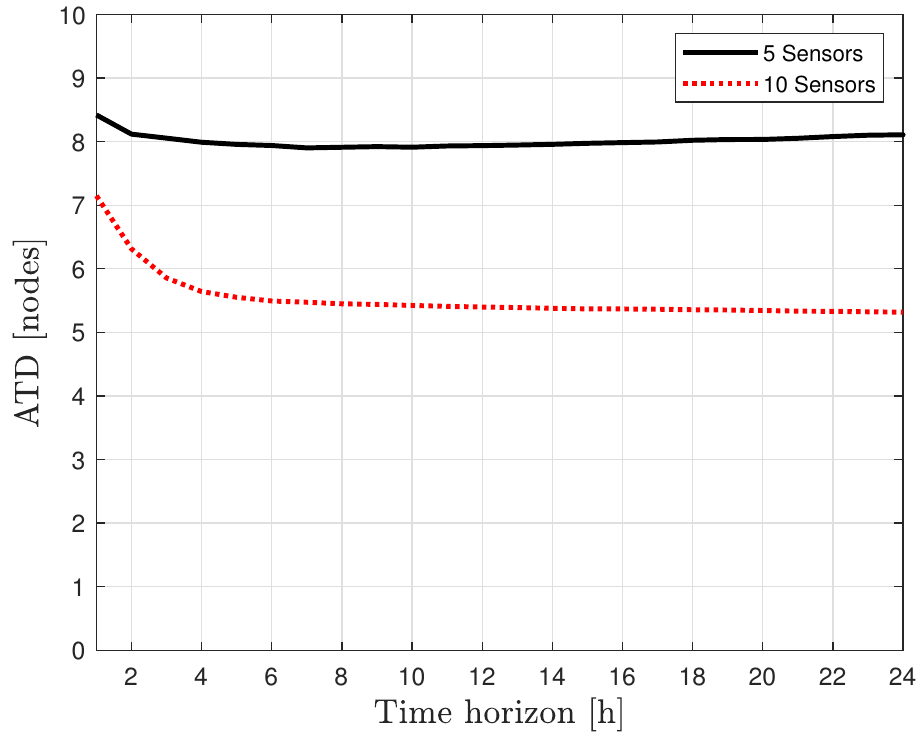
Figure 9. Evolution of the ATD.